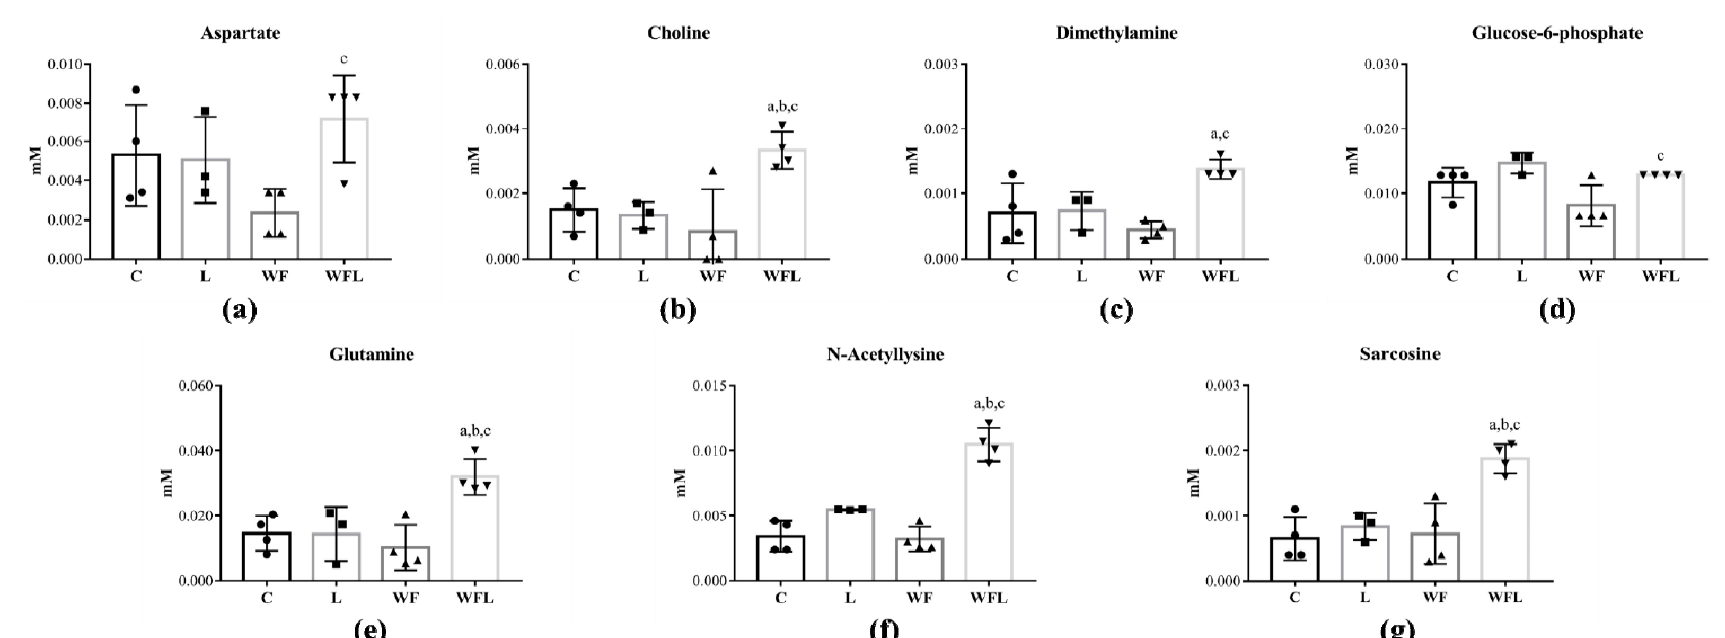
Figure 4. C 2 C 12 Myotube metabolic profile identified in C 2 C 12 cells. Concentration of ( a ) Aspartate; ( b ) Choline; ( c ) Dimethylamine; ( d ) Glucose-6-phosphate; ( e ) Glutamine; ( f ) N-Acetyllysine; ( g ) Sarcosine. C 2 C 12 myotube cells were distributed into control (C); leucine supplementation medium (L); Walker Factor treatment (WF) and Walker Factor treatment and leucine supplementation medium (WFL). Data were expressed as mean ± standard deviation (SD) and analysed by one-way ANOVA followed by Tukey. ( a ) p < 0.05 comparison to C; ( b ) p < 0.05 comparison to L and ( c ) p < 0.05 comparison to W.